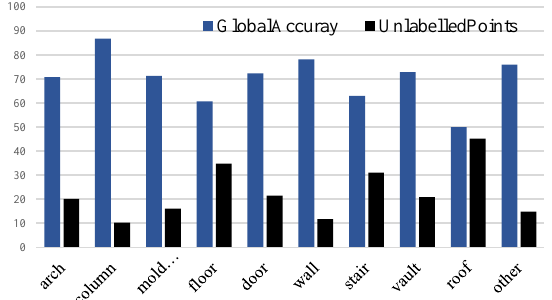
Figure 11 . Global Accuracy (blue) and unlabelled points percentage (black) for each class.